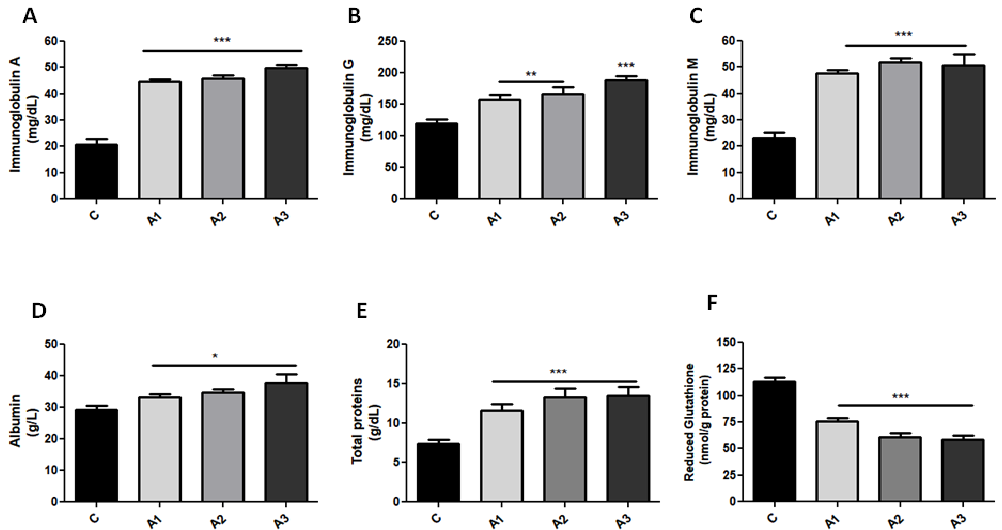
Figure 2. Comparisons of IgA ( A ), IgG ( B ), IgM ( C ), albumin ( D ), total proteins ( E ), and reduced glutathione ( F ) in serum of the control and allicin-treated animals. Allicin treatment induced a prominent increase in immunoglobulins as compared to the control group. Allicin in a dose of 5 mg / kg induced IgG values twice as high as in the control group, whereas albumin and total proteins were also increased. Glutathione pool was decreased after allicin administration. Values are expressed as mean ± SD (* p < 0.05; ** p < 0.01; *** p < 0.001).